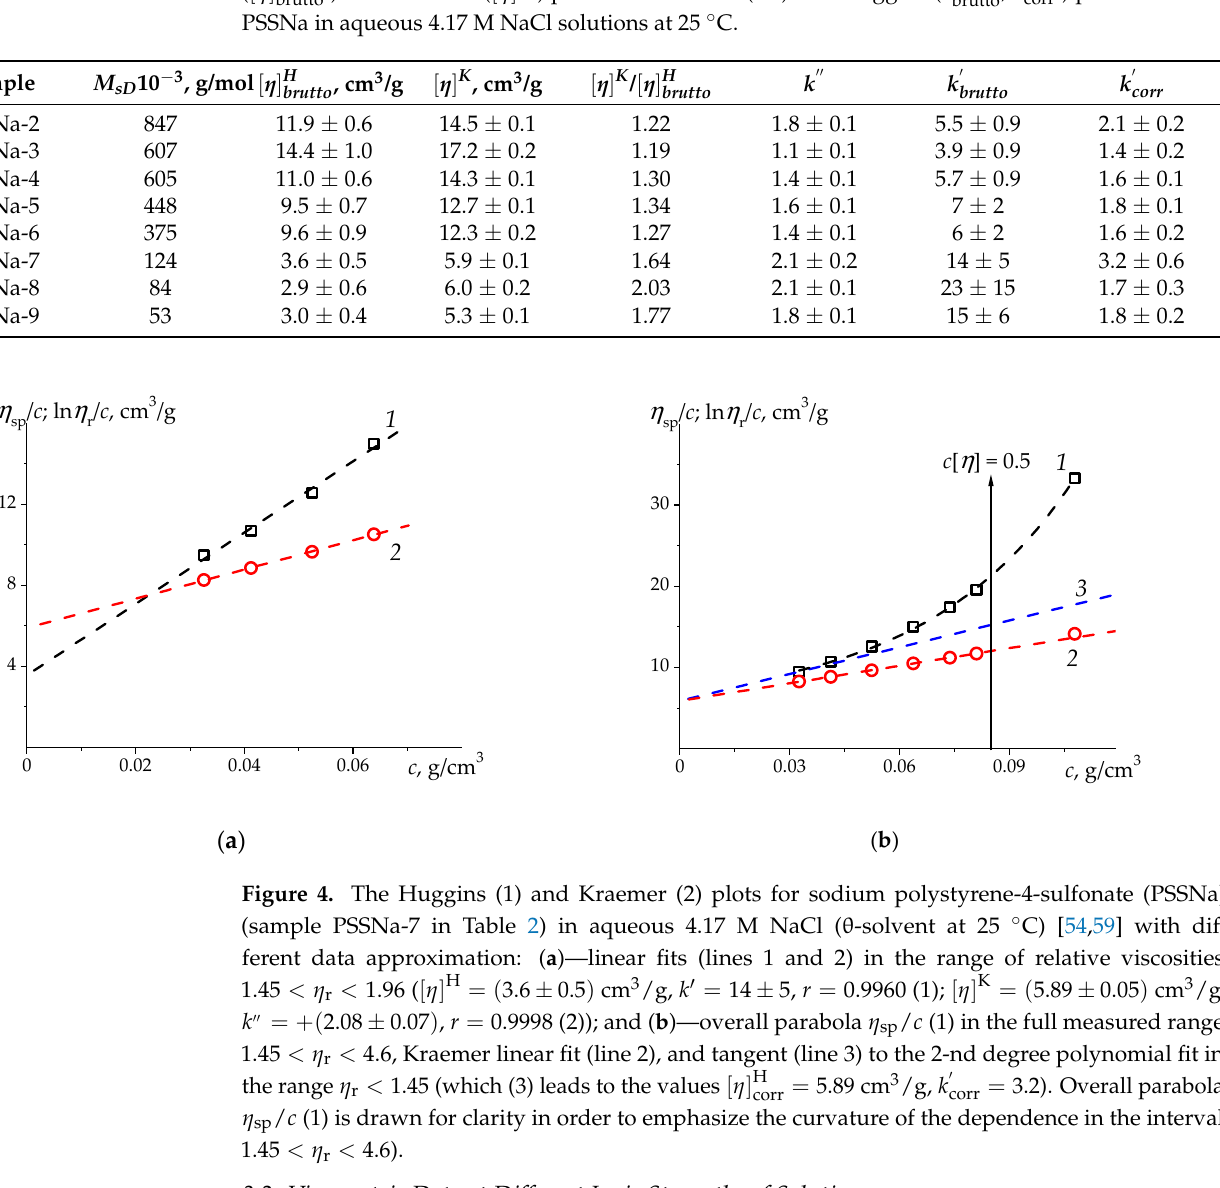
, k ’ corr ) parameters for brutto